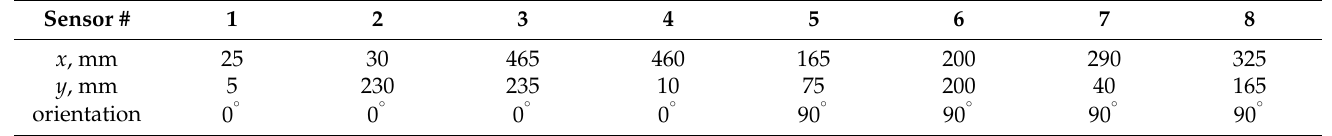
Figure 7. CFRP plates equipped with sensor network. SG refers to strain gauge, and the number corresponds to the sensor number in Table 1. Table 1. The configuration of the sensor network for the dynamic strain measurements.